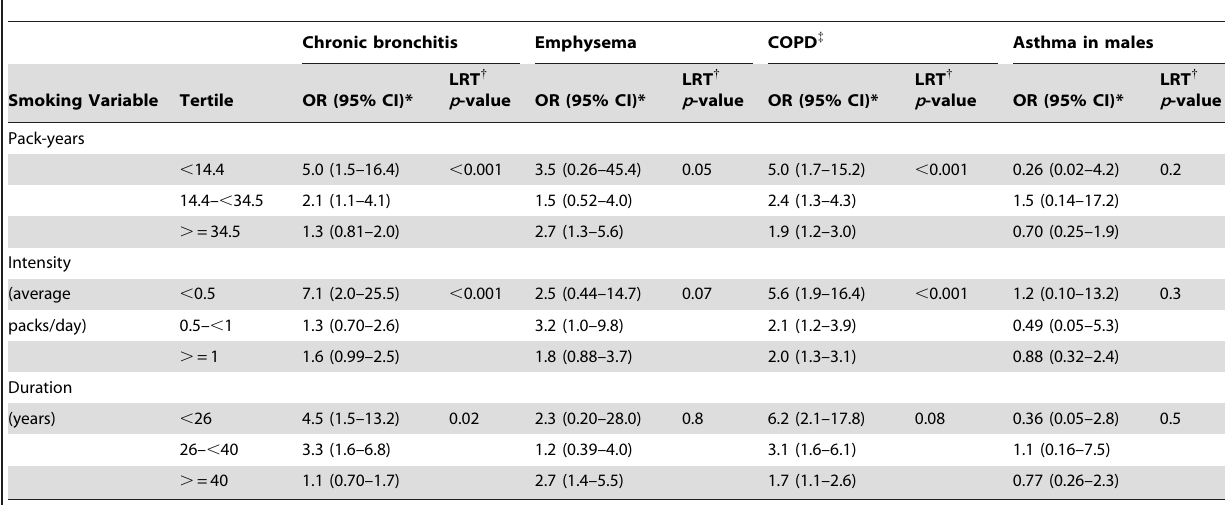
Table 4. Associations of lung cancer with lung disease diagnosed at least one year prior and lung cancer in the Environment And Genetics in Lung cancer Etiology case-control study restricted to current smokers (968 cases, 524 controls) and stratified by smoking status (tertiles among